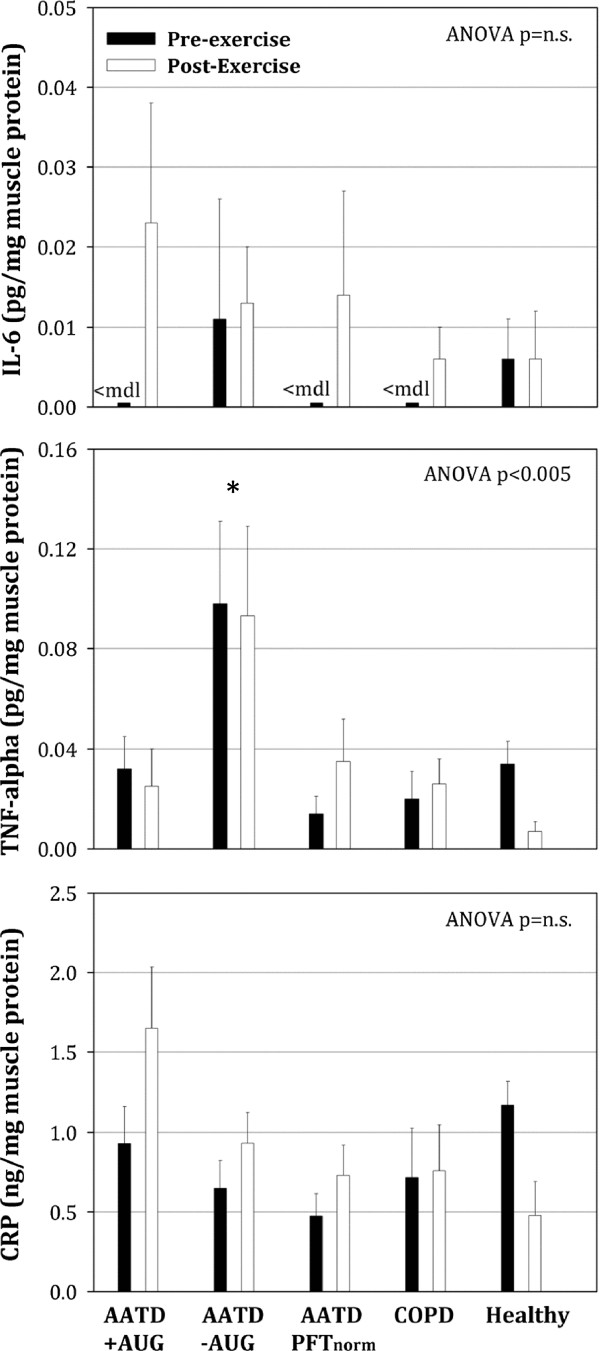
Skeletal muscle cytokine expression (normalized to total muscle protein) from muscle biopsies of vastus lateralis muscle before and after the 60-minutes of single-leg exercise. Pre-exercise biopsy was obtained on non-exercising leg prior to exercise, while post-exercise biopsy was obtained 4-hours post-exercise on the exercising leg. We provide indication where detection of cytokines fell below the minimal detectable limit (<mdl) of the assay, i.e. all samples for IL-1b (therefore no data shown) and for some samples in IL-6. Post-hoc testing was only performed on TNFα, where a significant ANOVA main effect (p < 0.005) was observed. No significant main effect was observed for IL-6, therefore post-hoc testing between groups was not performed. * indicates p < 0.05 compared to all other groups.